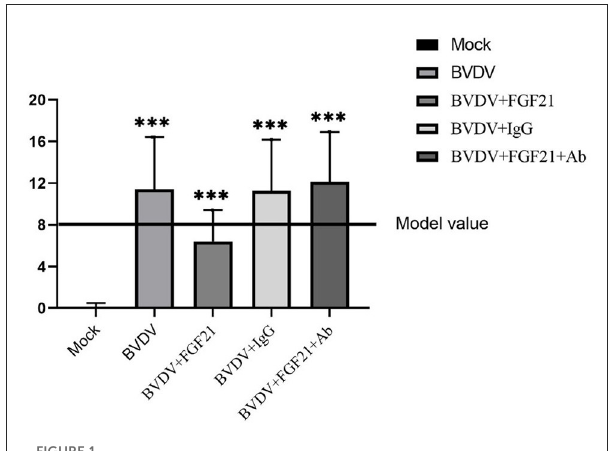
FIGURE1 BVD mouse model score